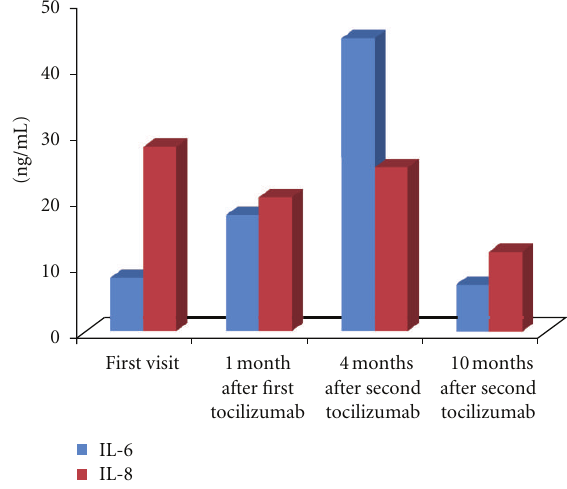
Figure 3: Serum concentrations of IL-6 and IL-8 before and after tocilizumab administration. Marked increases in the serum levels of IL-6 are observed 1 and 4 months after tocilizumab administration that did not a ff ect the serum levels of IL-8.